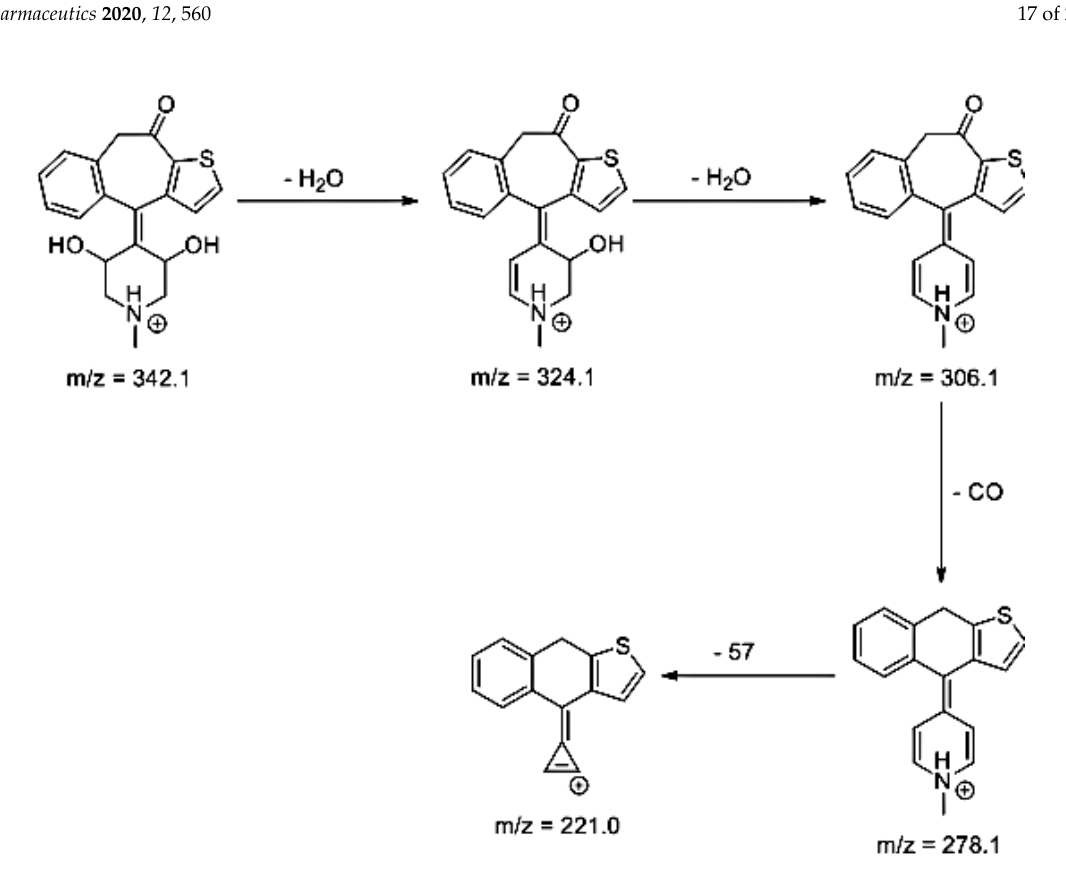
Figure 11. Proposed fragmentation pattern of KET-P1.